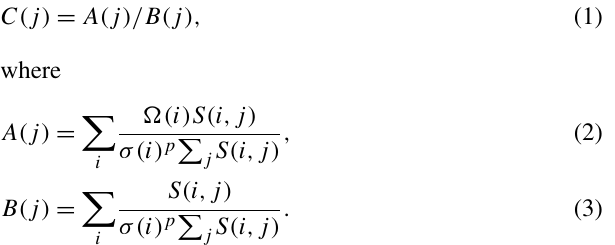
of 8 km to oversample the OMI NO 2 tropospheric columns and a larger radius of 24 km to oversample the OMI SO 2 total columns near the Canadian oil sands region; Fioletov et al. (2011) used 12 km to oversample the OMI SO 2 to- tal columns over the US; and Zhu et al. (2014) used 24 km to oversample the HCHO total columns near Houston,